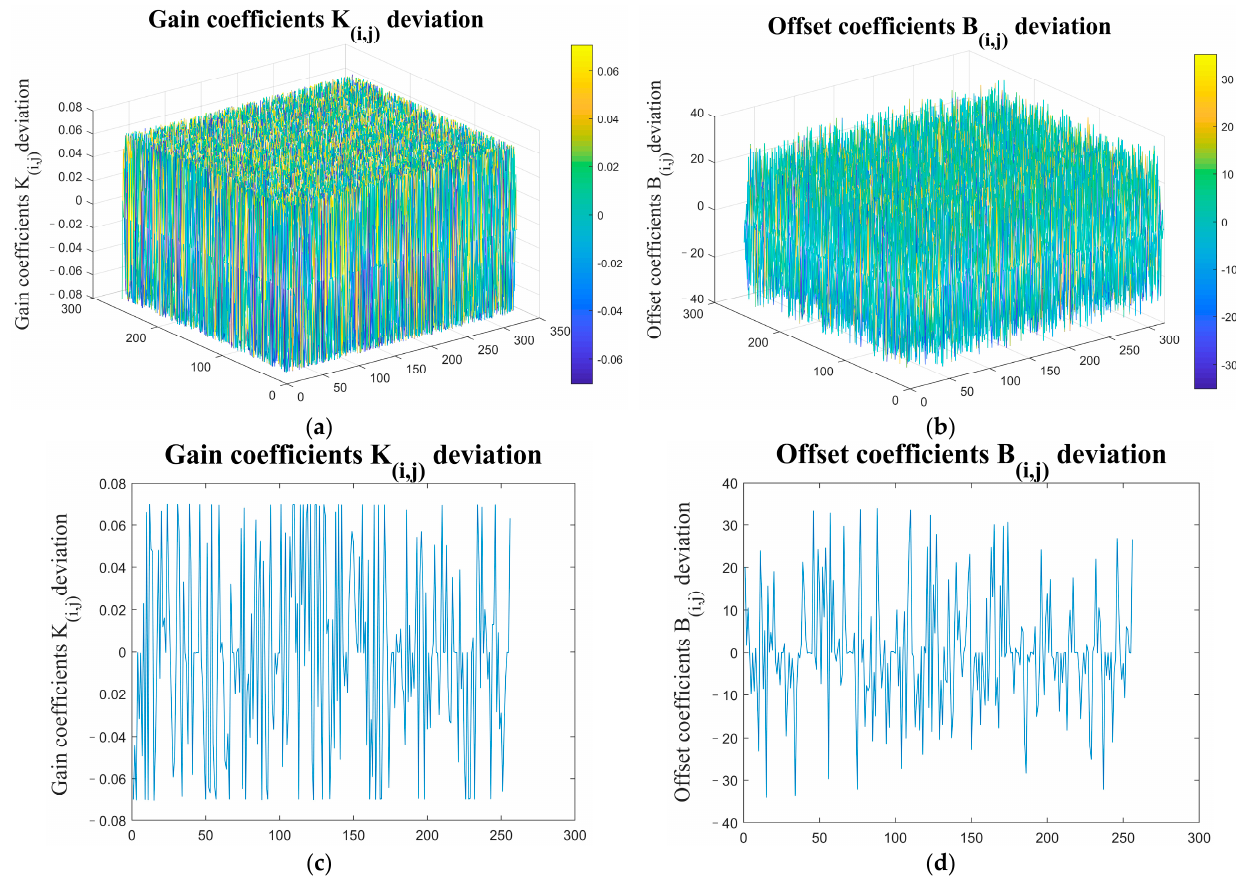
Figure 4. Comparison of correction coefficients between traditional model and modified model: ( a ) correction gain coefficients K i,j deviation; ( b ) correction offset coefficients B i,j deviation; ( c ) correction gain coefficients K i,j deviation in 190th column; ( d ) correction offset coefficients B i,j deviation in 190th column.